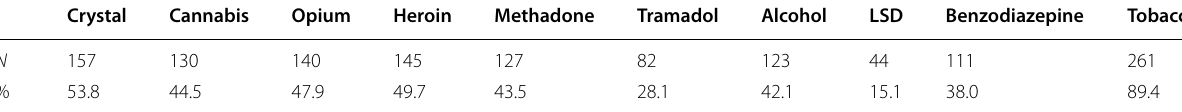
Table 2 Frequency of different substances used by patients with substance use disorder Crystal